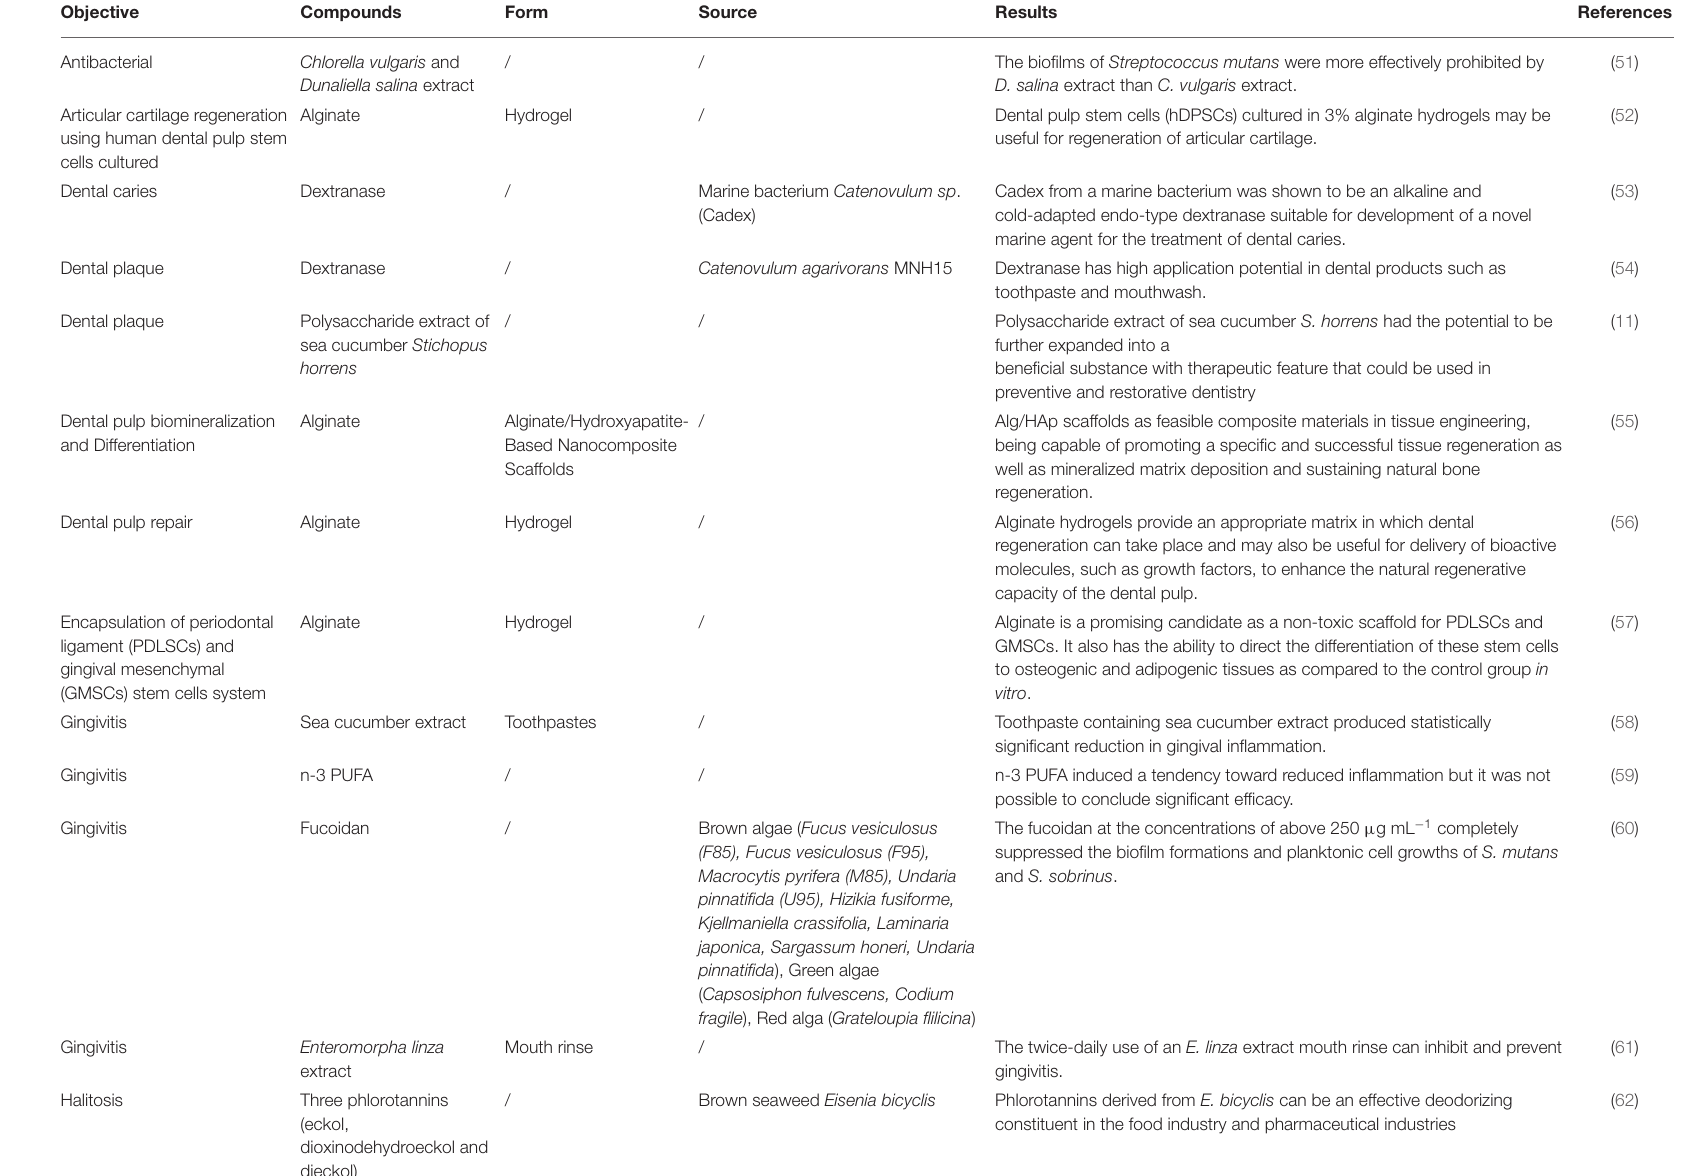
TABLE 1 | List of marine active ingredients for various oral diseases and their causative